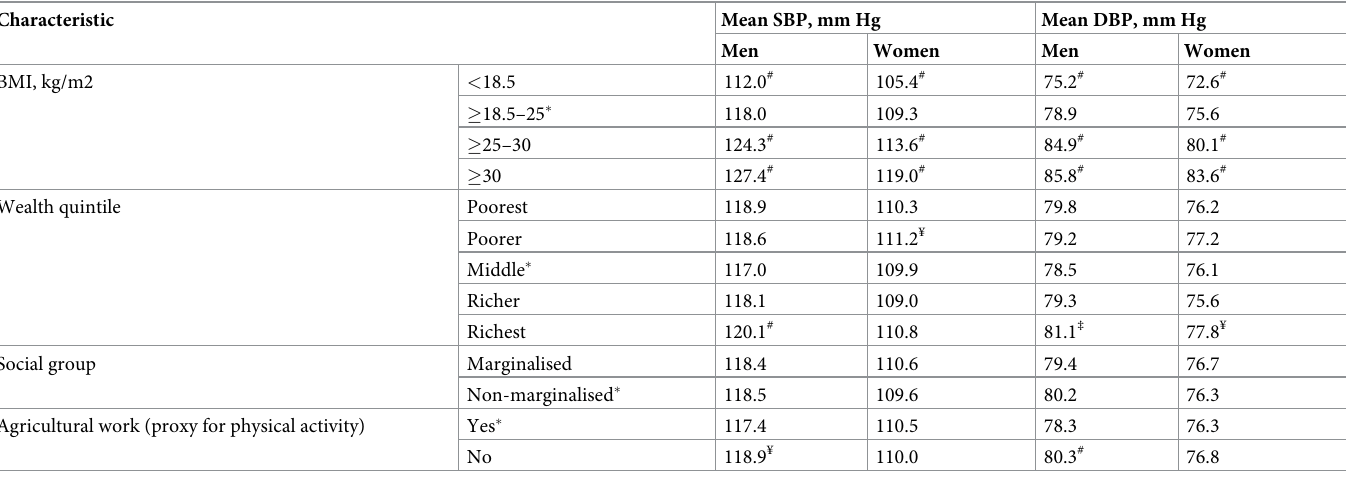
Table 2. Age-adjusted mean SBP and DBP by confounding variables. Characteristic